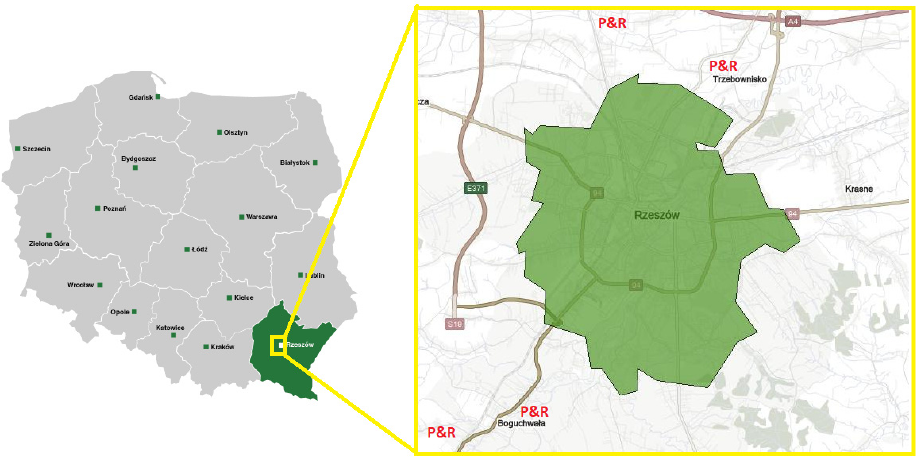
Figure 4. Overview map of the research area showing the locations of P&R spaces.